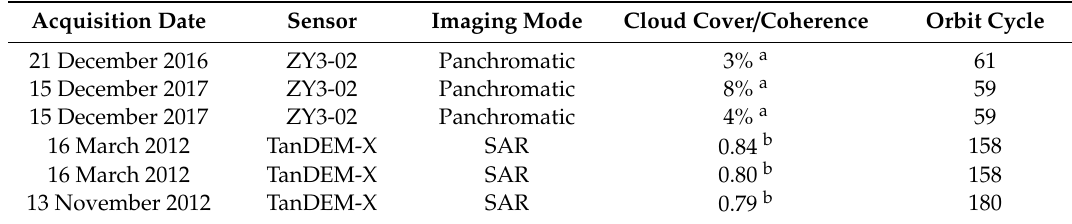
Table 1. Main parameters of the used ZY3 images and TanDEM-X